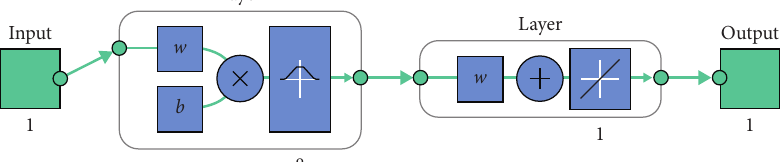
Figure 4: Neural network diagram for original training dataset [14].